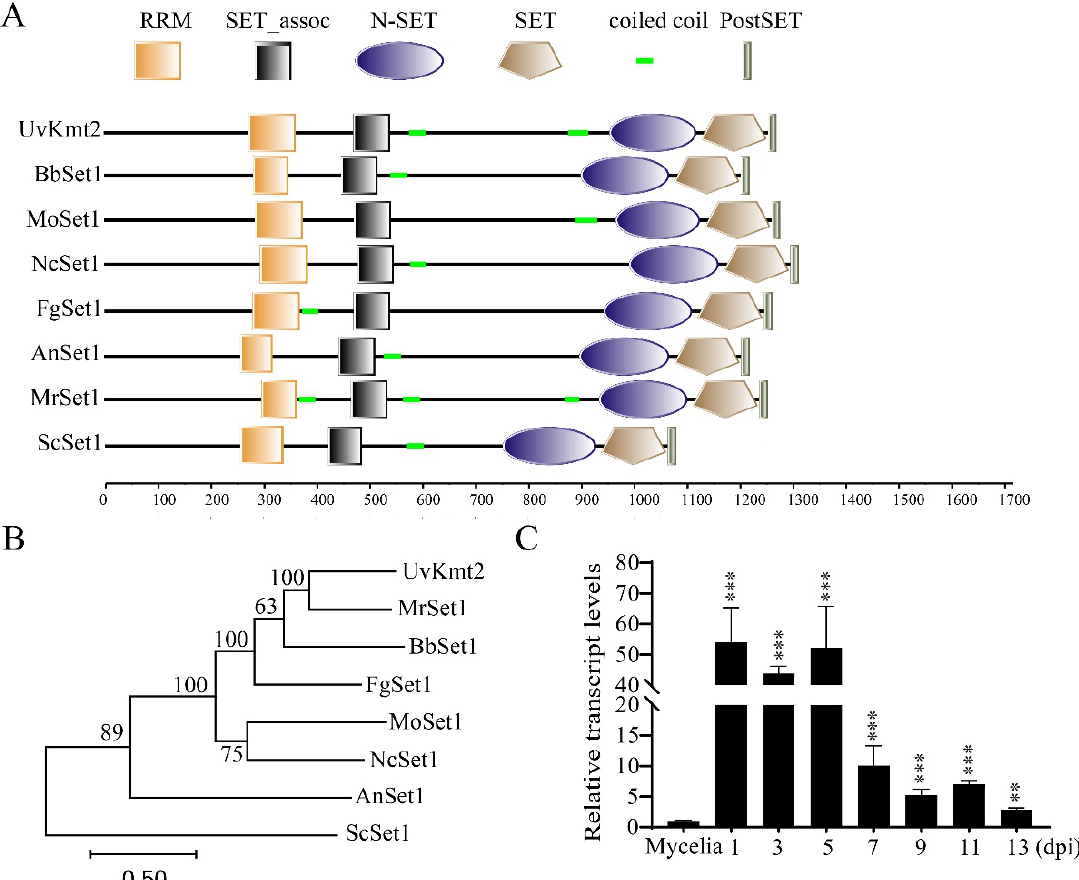
Figure 1. Identification of UvKMT2 in U. virens . ( A ) Functional domain analysis of Kmt2 homologs. The Kmt2 homologs include Ustilaginoidea virens Kmt2 (XP_042996622.1), Beauveria bassiana Kmt2 (XP_008600524.1), Magnaporthe oryzae Set1 (XP_003715029.1), Neurospora crassa Set1 (XP_961572.3), Fusarium graminearum Set1 (XP_011327217.1), Aspergillus nidulans Set1 (XP_663399.1), Metarhizium robertsii Set1 (XP_007823015.2), and Saccharomyces cerevisiae Set1 (NP_011987.1) were analyzed. ( B ) Phylogenetic tree of Kmt2 homologs was constructed using MEGA 7.0 with the neighbor-joining algorithm. The numbers close to the branch nodes are bootstrap values. ( C ) Expression pattern of UvKMT2 was determined by qRT-PCR assay. The expression level of UvKMT2 during infection process was calibrated to that of mycelia. The β -actin gene served as the internal control. The data represent the mean ± SD from three biological replicates. ***, p < 0.001; **, p < 0.005.